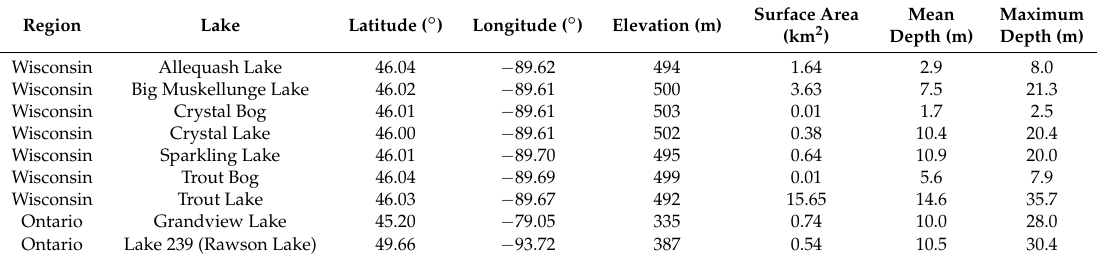
Table 1. Morphometric and geographic characteristics of the nine north temperate study lakes.